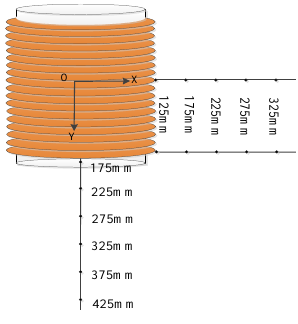
Figure 16. Distribution of measuring points.